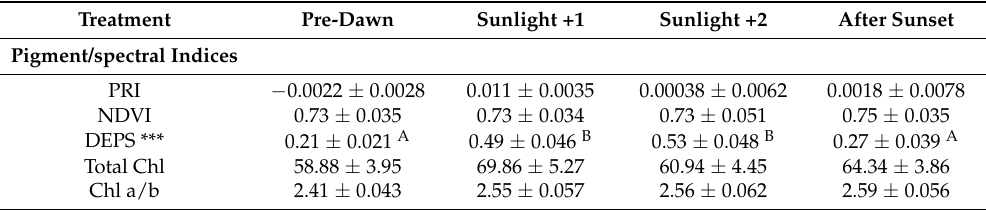
Table 2. Leaf pigment composition and spectral indices measured from avocado leaf discs collected at one of four different time points: before sunrise (pre-dawn), 1 h (sunlight +1) and 2 h (sunlight +2) after direct sunlight exposure and after sunset. Leaf spectral indices (PRI and NDVI) were taken from diurnal measurement with a QE Pro spectroradiometer. Violaxanthin de-epoxidation status (DEPS), Chl a/b and total Chl were determined via HPLC, where total Chl is given in µ g · cm − 2 . All data represents the mean ± SE ( n = 30) of avocado leaf discs collected at SHF for each treatment. Significant differences between treatments are marked by ***. Treatments not connected by the same letter are significantly